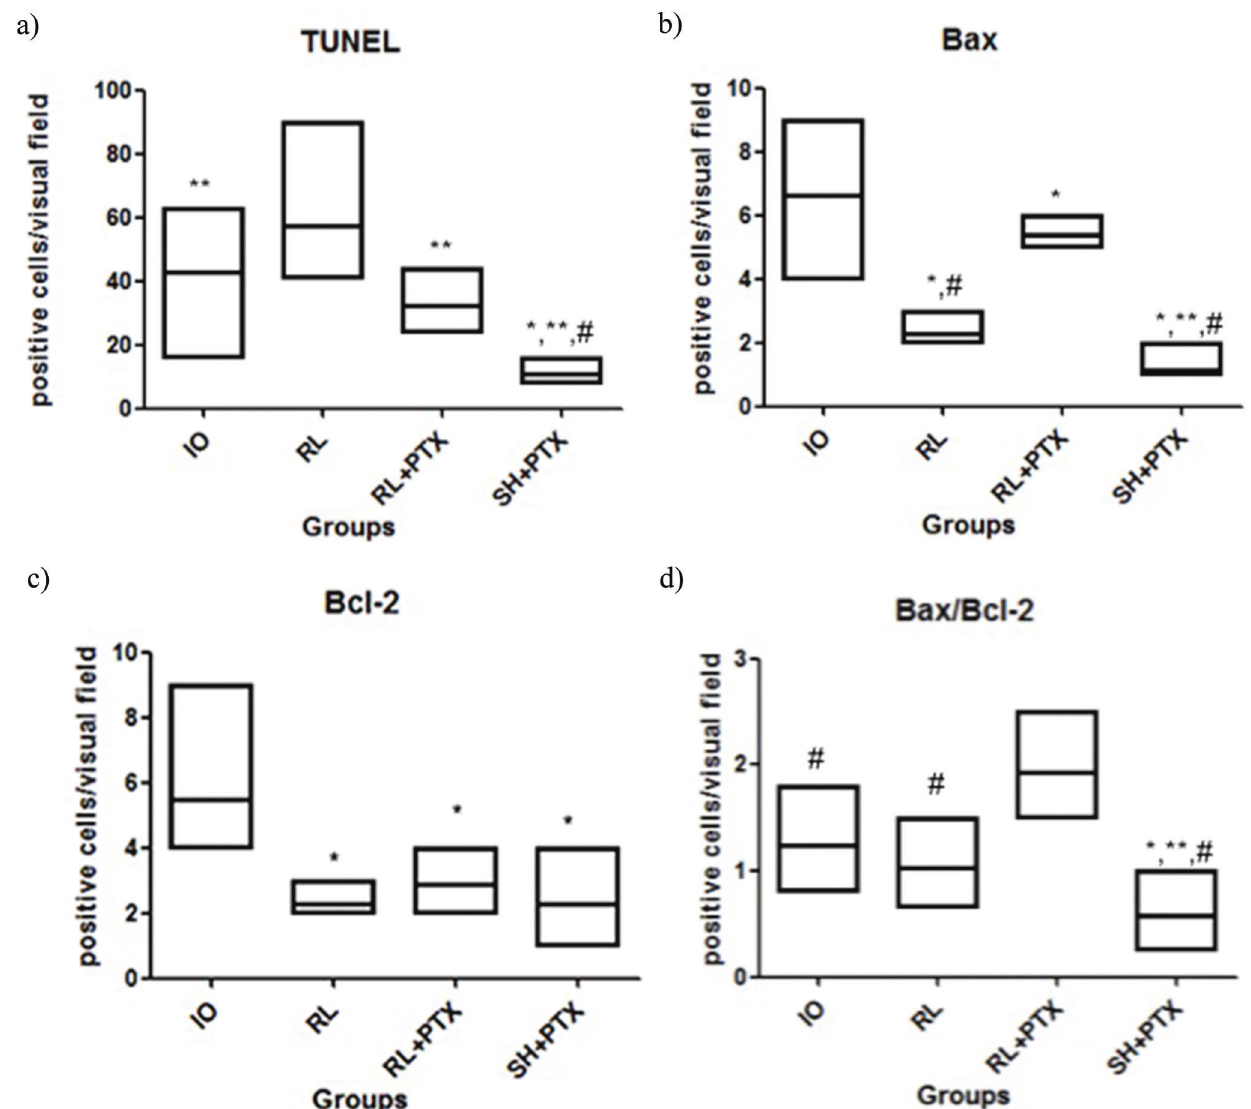
Figure 3 - Expression of apoptosis in the kidney by immunohistochemical staining (positive cells/visual field): TUNEL (a), Bax (b), Bcl-2 (c), Bax/Bcl-2 (d). Wistar rats were assigned to four groups: no resuscitation (IO-intestinal obstruction and ischemia), Ringer ’ s lactate (RL), Ringer ’ s lactate + pentoxifylline (RL + PTX), and hypertonic saline + pentoxifylline (HS + PTX). The data are expressed as the medians (interquartile range). ( p o 0.05) * versus IO; ** versus RL; # versus RL +